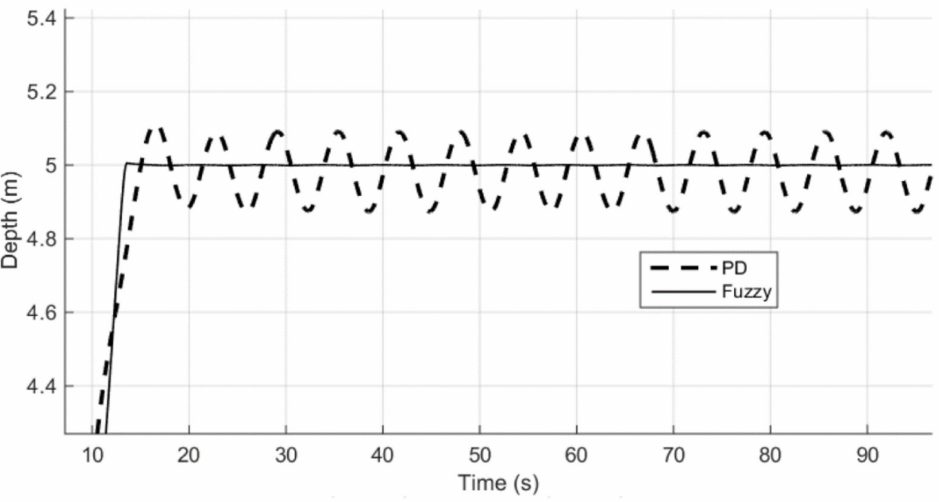
Figure 8. Graph of the given and the current depth of the AUV versus time with harmonic exogenous